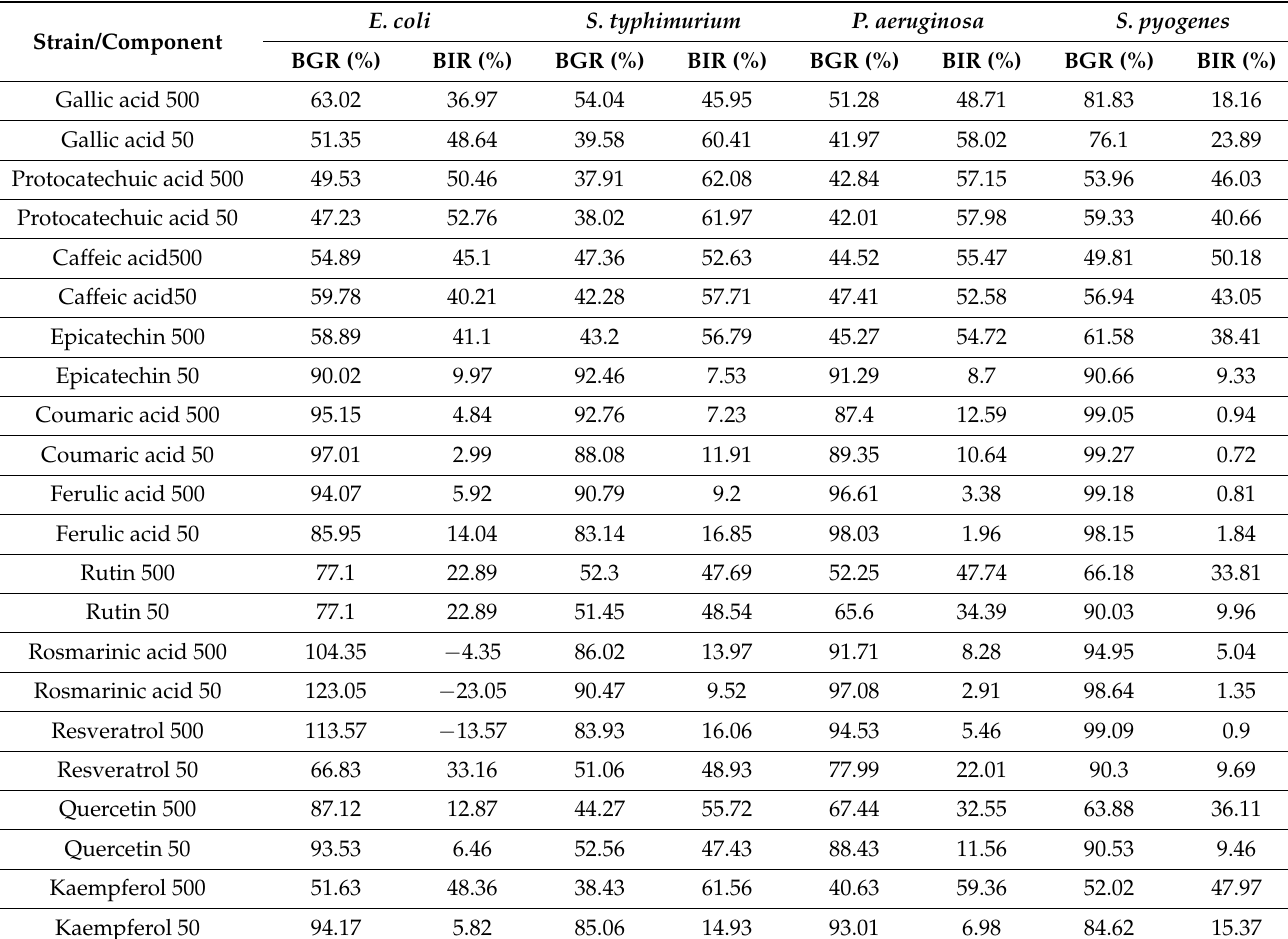
Table 3. The efficiency of identified standards on the four sensitive strains